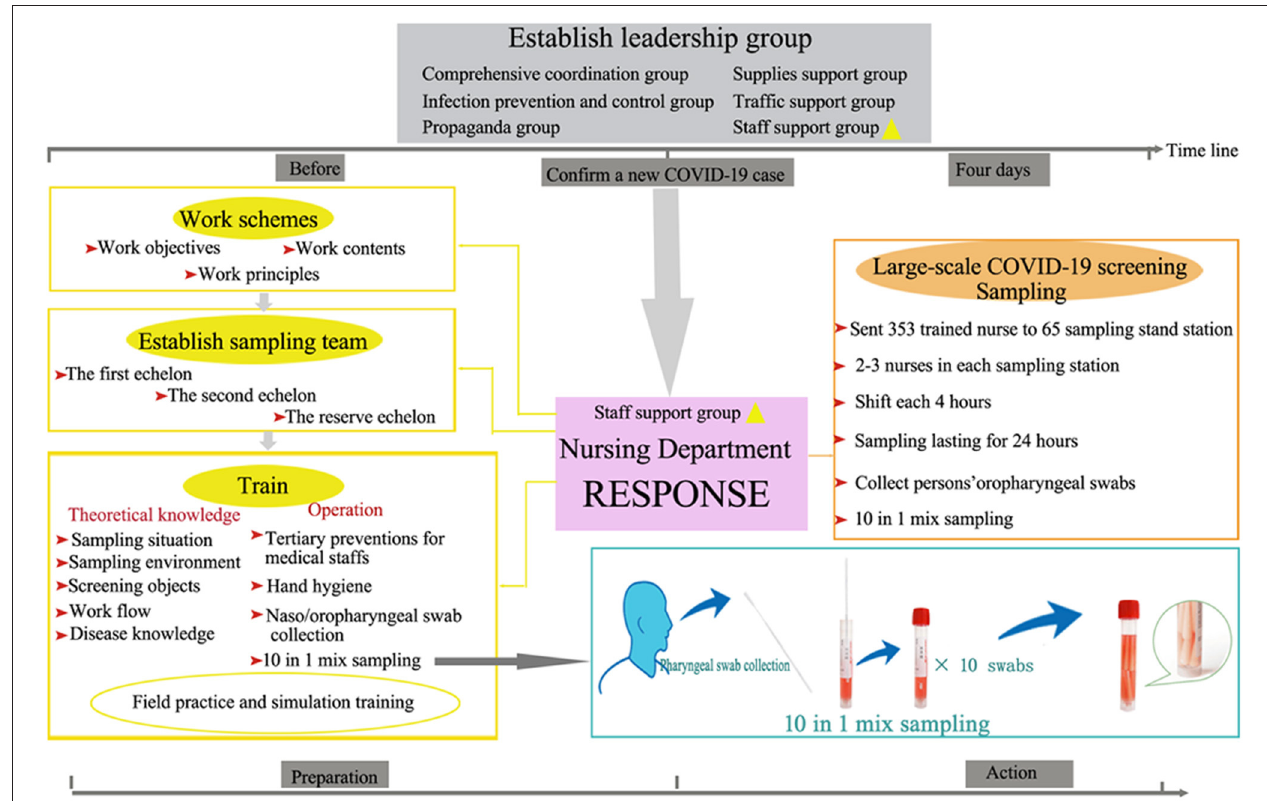
FIGURE 1 | Nursing team response to large scale COVID-19 Screening. The response strategy included previous preparation and effective action. Each step was indispensable. The 10 in 1 mix samples technique which is different from pooling samples was applied in this